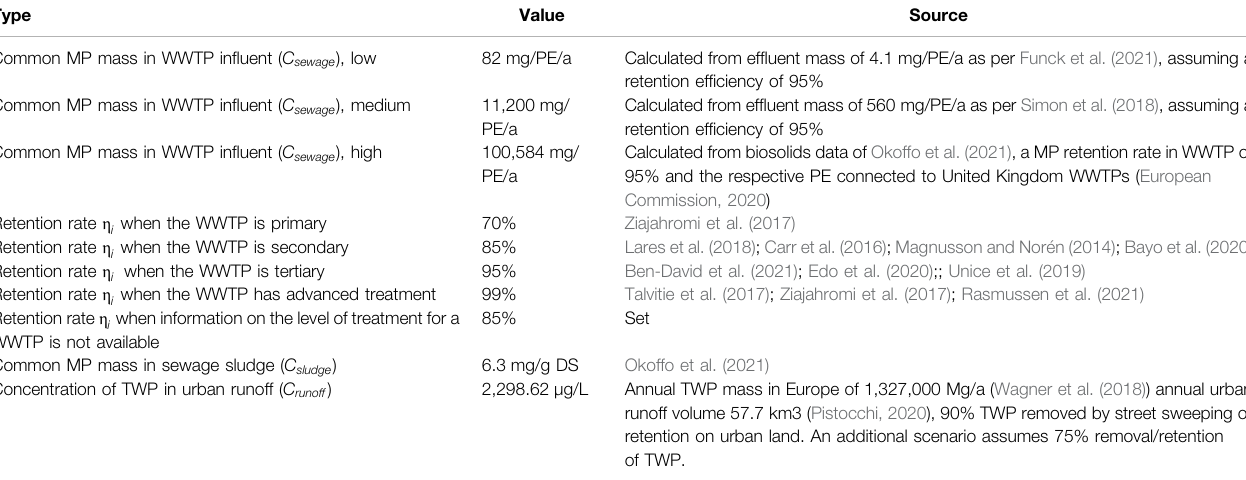
TABLE 1 | Parameters taken from current literature re fi ning the European MP fl ow